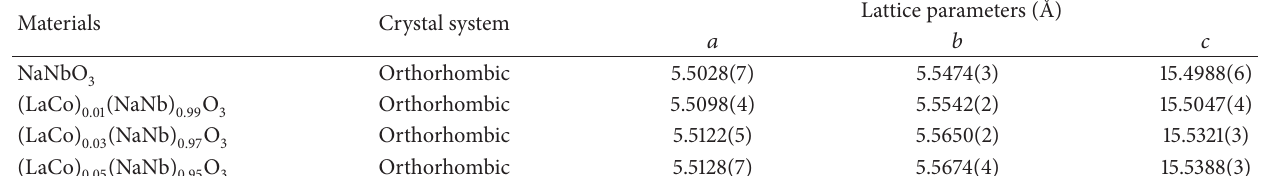
Table 1: Crystal structures of the as-prepared doped and undoped NaNbO